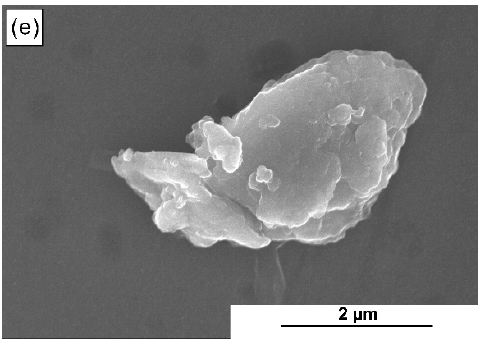
Figure 1. ( a ) Morphology of the obtained MAX phase; ( b ) XRD analysis of the obtained MAX phase; ( c ) morphology of the expanded Ti 3 C 2 MXene; ( d ) morphology of 2D Ti 3 C 2 T x crystals; ( e ) morphology of 2D Ti 3 C 2 T x M crystals.